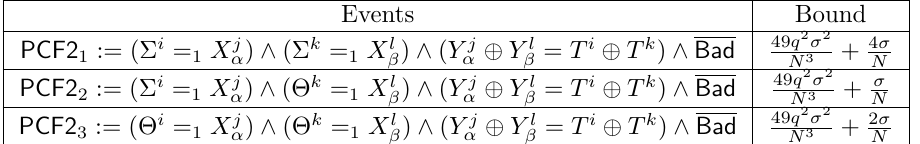
Table 6: Bound for the joint event (i) PCF2 1 ∧ Bad (ii) PCF2 2 ∧ Bad and (iii) PCF2 3 ∧ Bad . Events